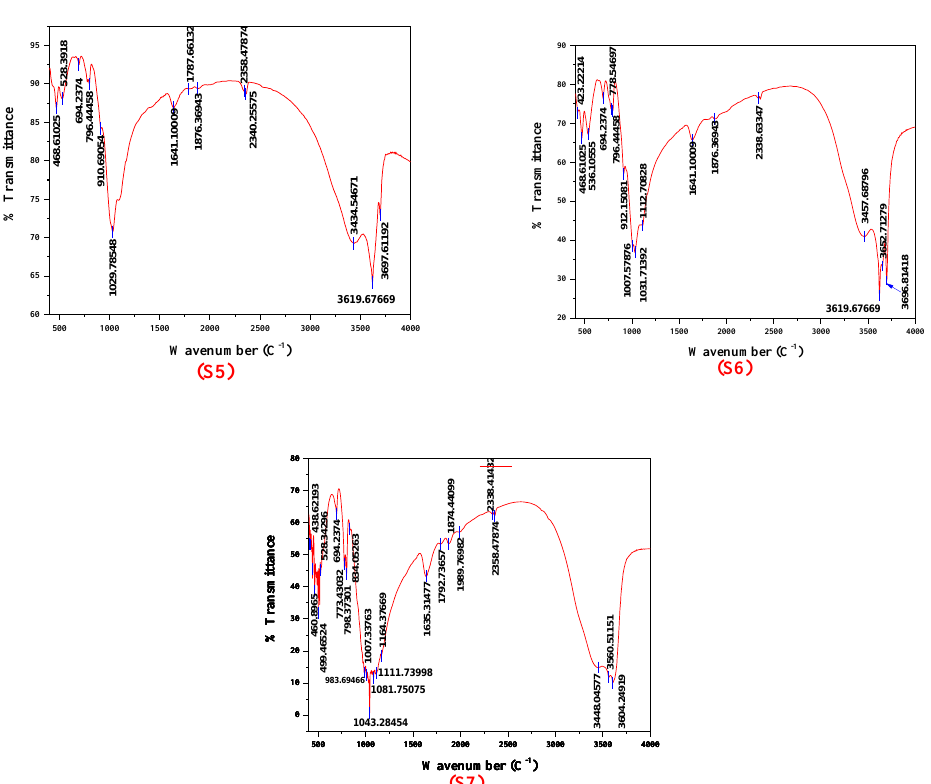
Figure 5. Evolution of stretching bands in the FTIR spectra of clay samples (S1, S2, S3, S4, S5, S6, and S7). The presence of bands around ~1084, ~797, ~778, ~695, and ~468 cm −1 indicated that all clay samples contained the quartz phase. This supports the XRD results of clay samples (Figure 2).